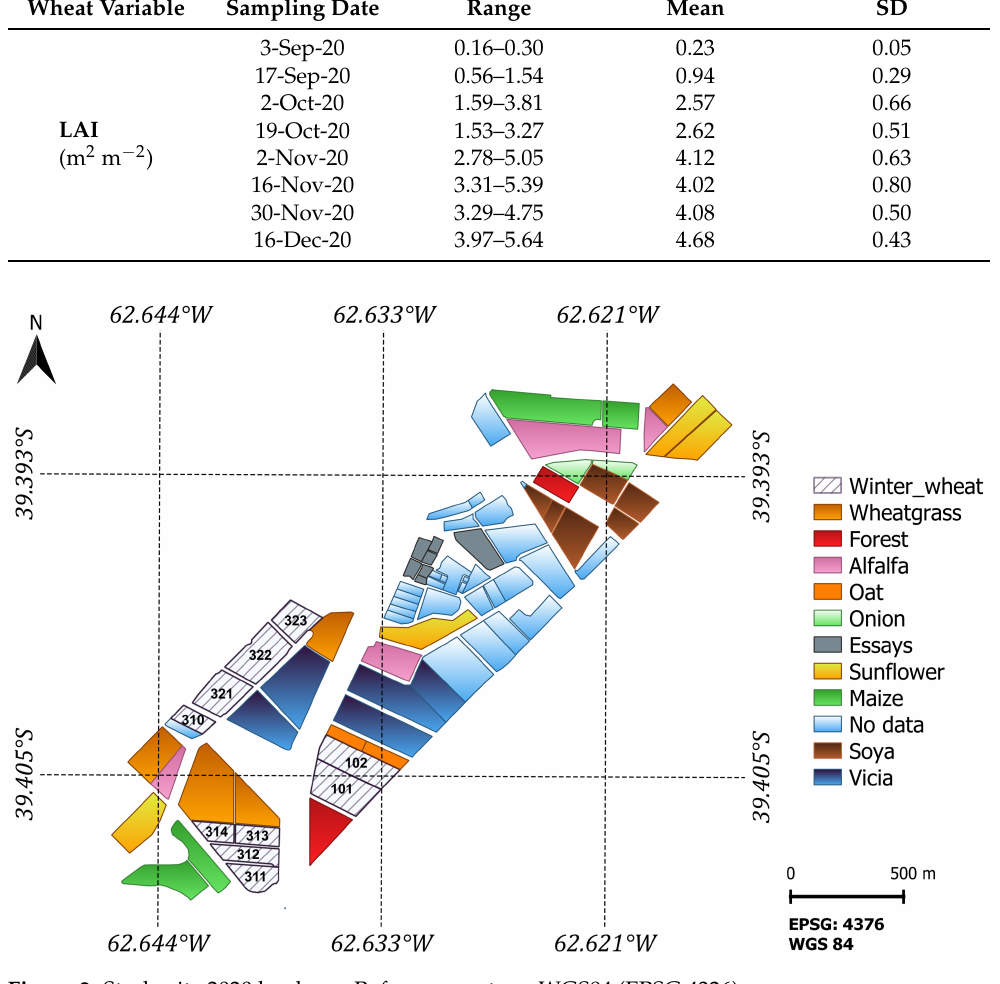
Figure 2. Study site 2020 land use. Reference system: WGS84 (EPSG